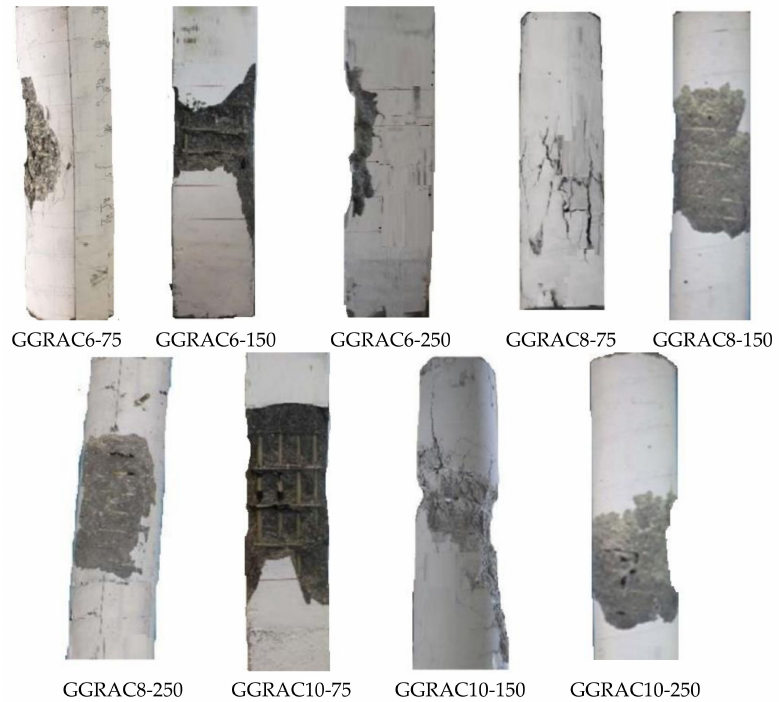
Figure 5. Crack initiation of GGRAC compressive members.